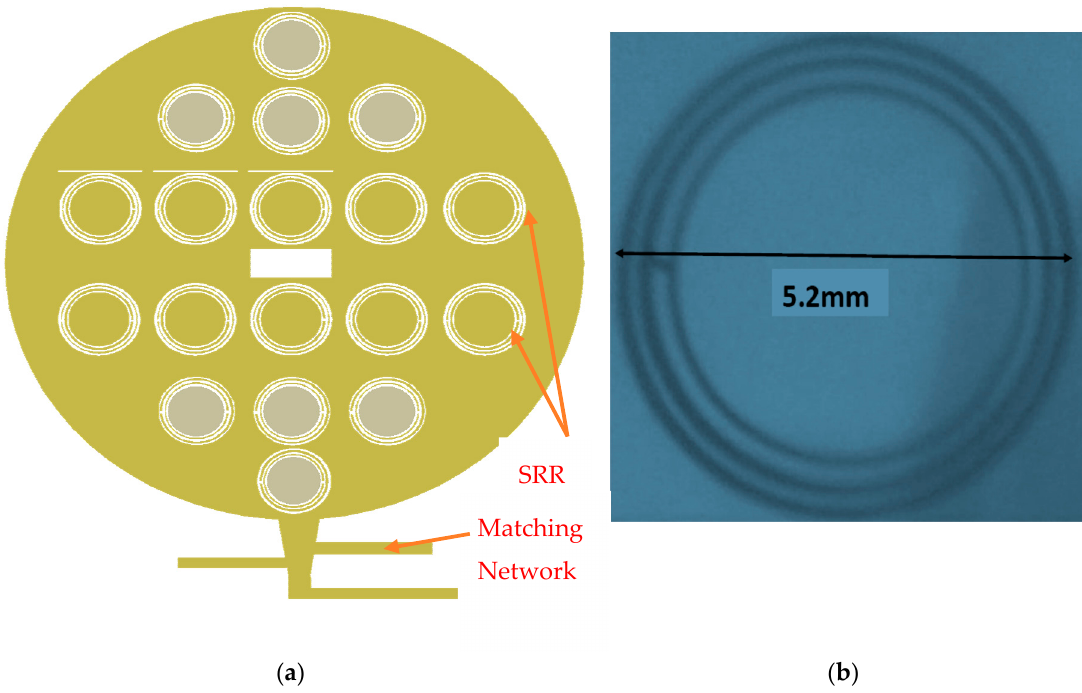
Figure 2. ( a ) Circular microstrip antenna with Circular Split-Ring Resonators (CSRR); ( b ) Photo of a single CSRR.